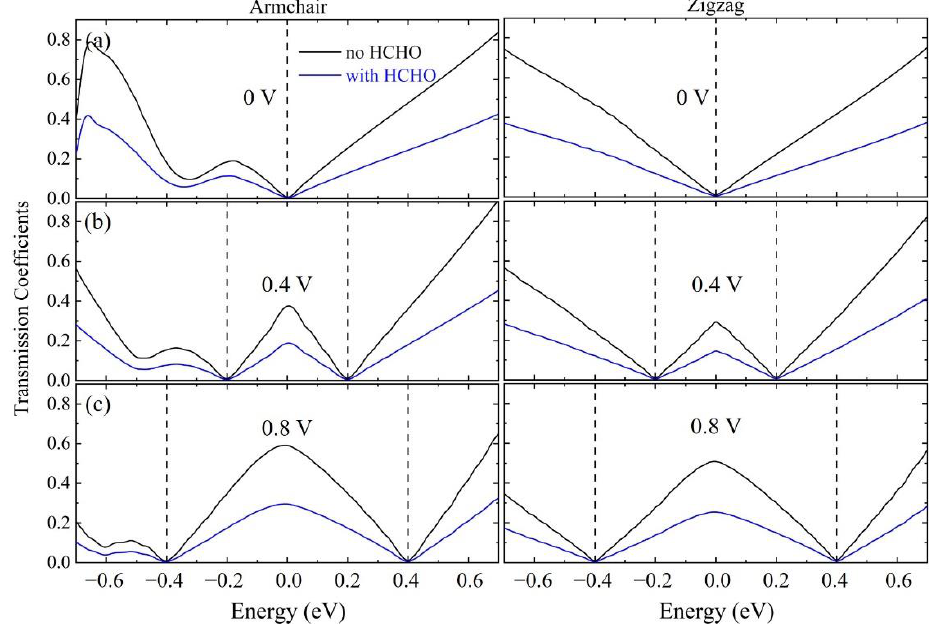
Figure 7. The transmission spectra of the AlG nano-sensor for HCHO detection along armchair and zigzag directions under the bias voltage of ( a – c ) 0, 0.4, and 0.8 V. The black dashed lines represent the bias windows.